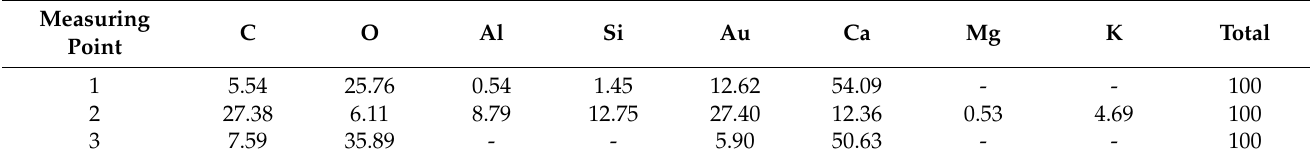
Table 6. Mass share of elements detected in EDS analysis of the reclaimed asphalt pavement (RAP) at measuring points